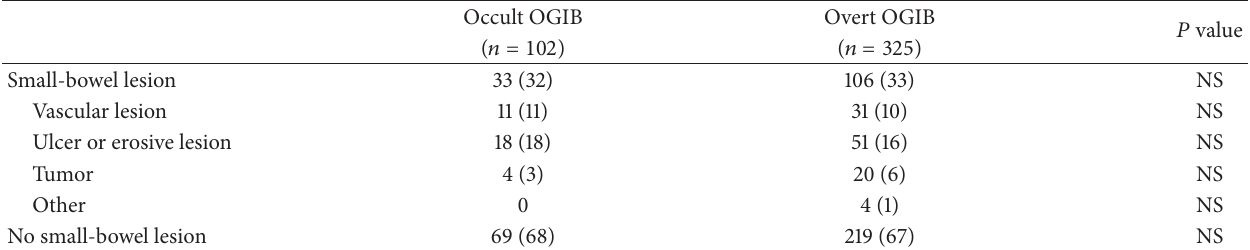
Table 2: Final diagnoses per study